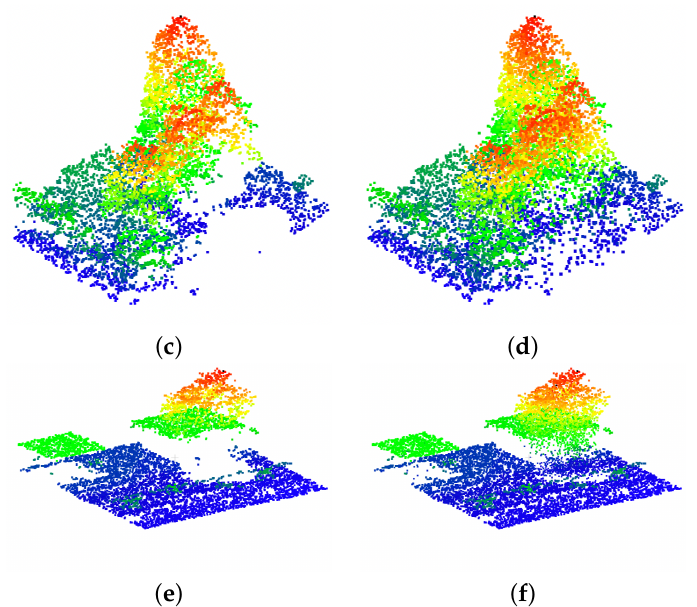
Figure 10. Example scenes of the reconstructed point clouds from our method on the DALES Viewpoints Version 2 dataset. All point clouds are colored by height.The images show the input point cloud, with occlusions on the left-hand side, with the right hand-side showing the same point cloud with additional points added by our network to fill the occluded area.